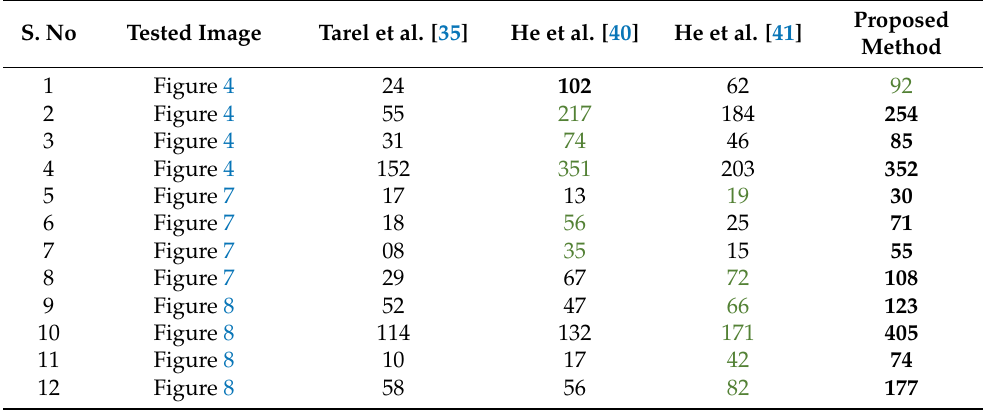
Table 2. Quantitative comparison of feature-points matching obtained from different